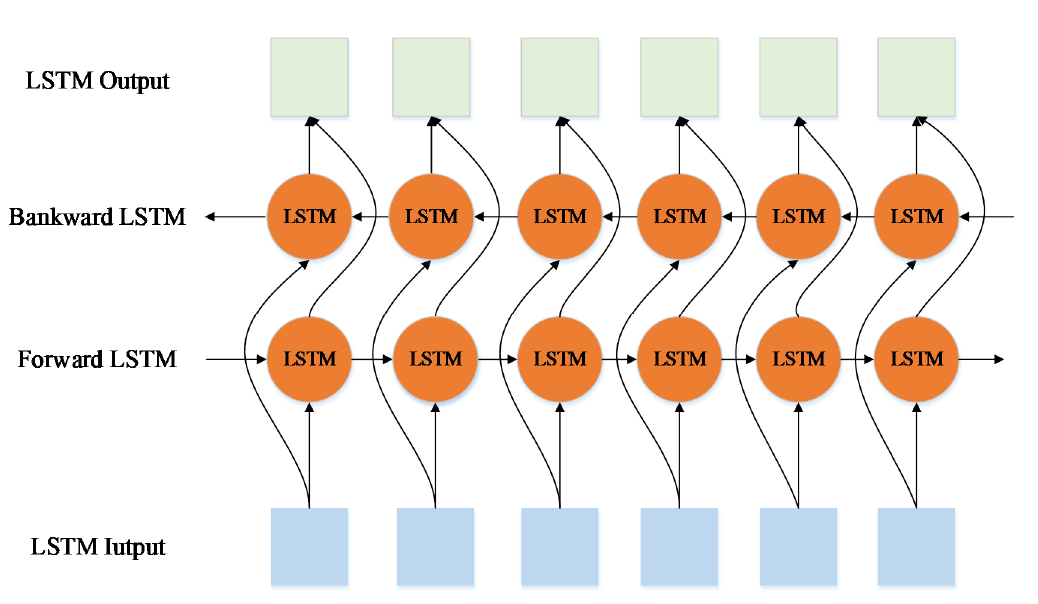
Figure 9. Bidirectional Long Short-Term Memory model.